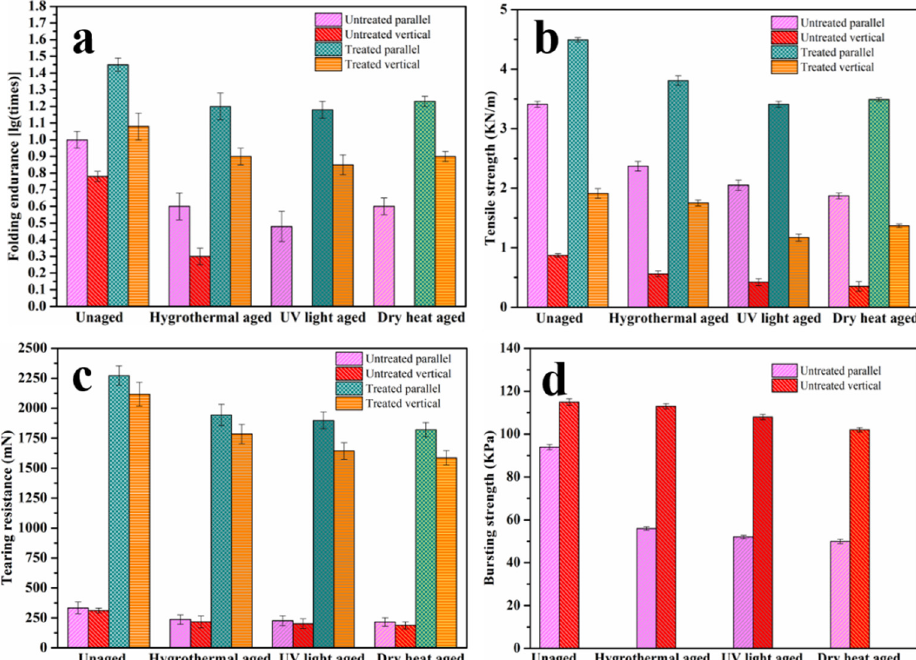
Figure 3. Test results of the mechanical properties of simulated samples before and after aging and restoration were as follows: folding endurance ( a ); tensile strength ( b ); tearing strength ( c ); bursting strength ( d ).